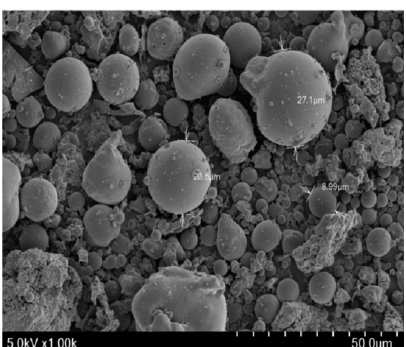
Figure 19. SEM image observed for fly ash cenosphere [59].